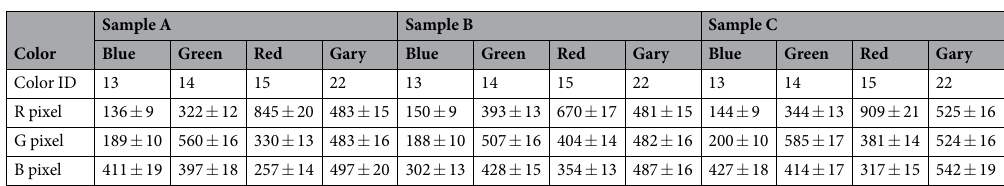
Table 1. RGB color pixel outputs of X-Rite, ColorChecker chart panels, as shown in Fig. 6. The data unit is digital count after optical black level subtraction and white-balancing. The data are averaged over 200 × 200 pixels for each color